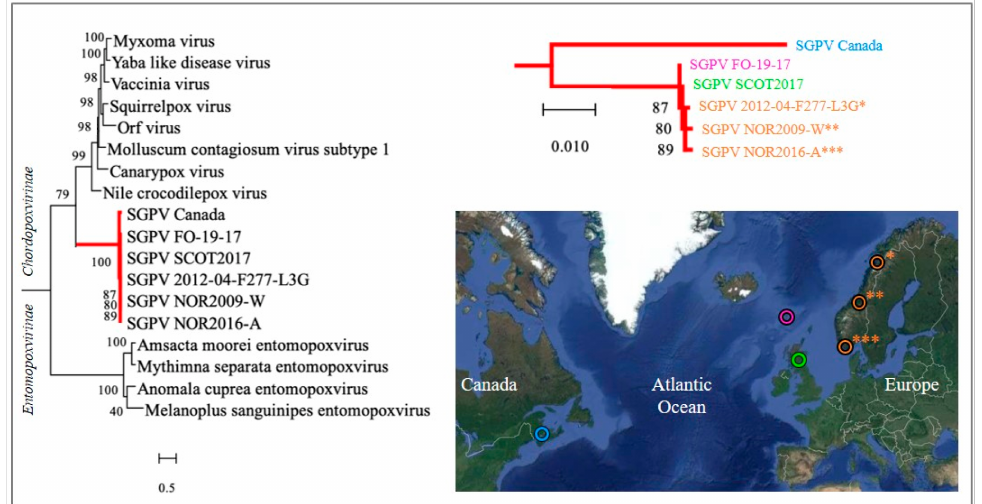
Figure 6. Maximum likelihood phylogeny of SGPV strains. SGPV phylogeny in relation to other poxviruses (left) and within SGPV (upper right). The map on the lower right shows the Atlantic origin of the included SGPV strains (see colours). Phylogenetic analysis was based on concatenated amino acid sequences from the major capsid protein and DNA-directed RNA polymerase subunit beta. Figure modified from Gulla et al. 2020